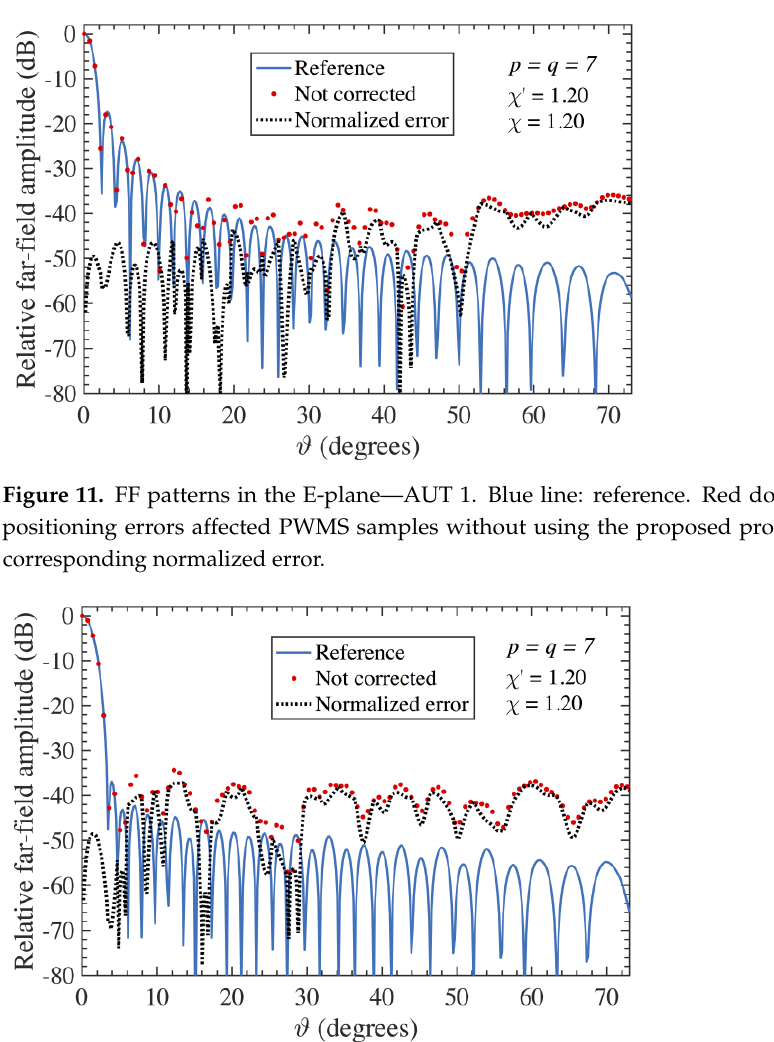
Figure 12. FF patterns in the E-plane — AUT 2. Blue line: reference. Red dots: attained from the positioning errors affected PWMS samples without using the proposed procedure. Dashed line: corresponding normalized error.